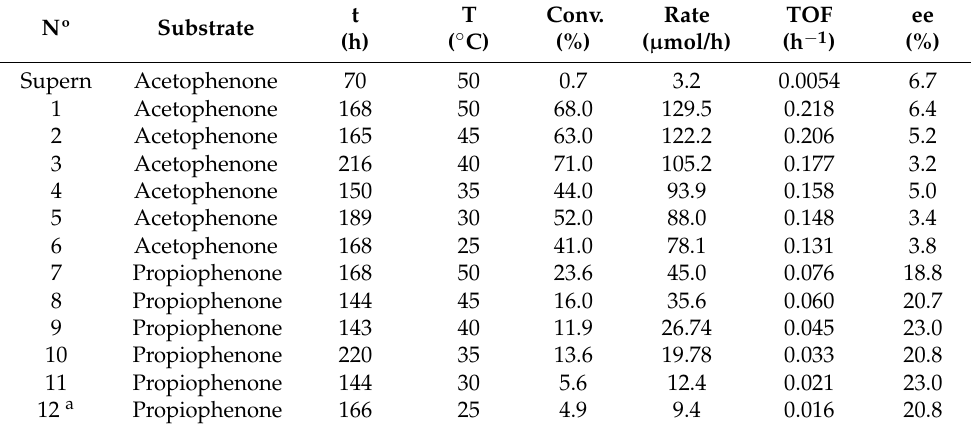
Table 5. Successive hydrogenation rates of Acetophenone and Propiophenone, to obtain phenylethanol and 1-fenil-1-propanol, respectively, carried out with the complex [Ru II Cl(bpea){(S)(-)(BINAP)}](BF 4 ) (593.6 µ mol), covalently attached to 4 g of AlPO 4 –Sepiolite, with 0.032 mol of substrate, in methanol, 40 mL, as solvent, at different temperatures, different reaction times and 90 atm of hydrogen pressure. Enantiomeric excess as well as TOF values are also